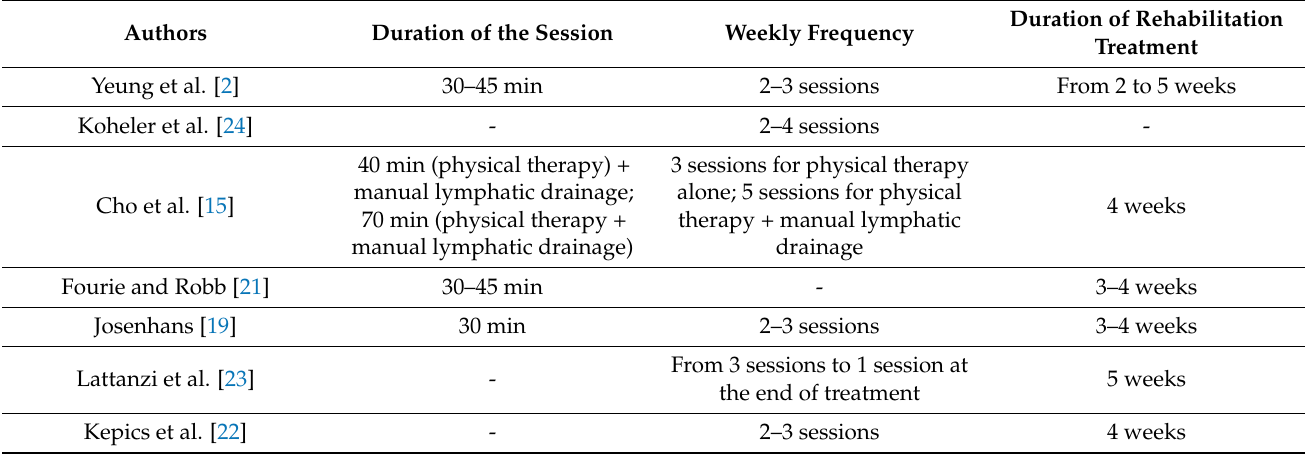
Table 1. Timing of rehabilitation and